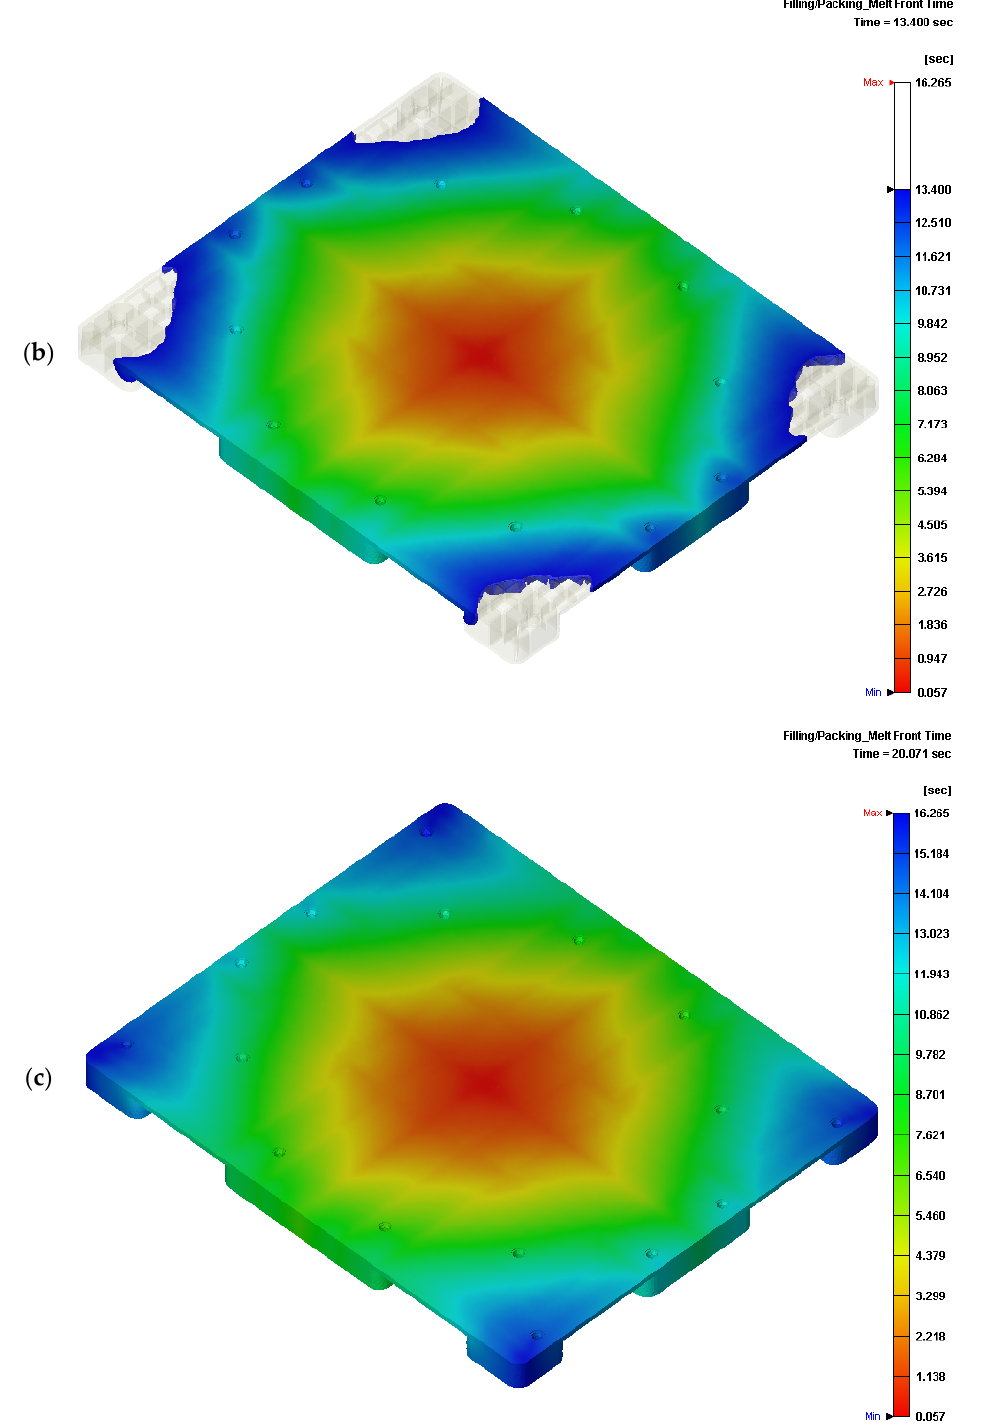
Figure 3. Spreading of the molten HDPE during filling and compression stages of ICM: ( a ) flow front from the filling gate at 6.729 s; ( b ) flow front from the filling gate at 13.40 s; ( c ) flow front from the filling gate at 16.265 s.